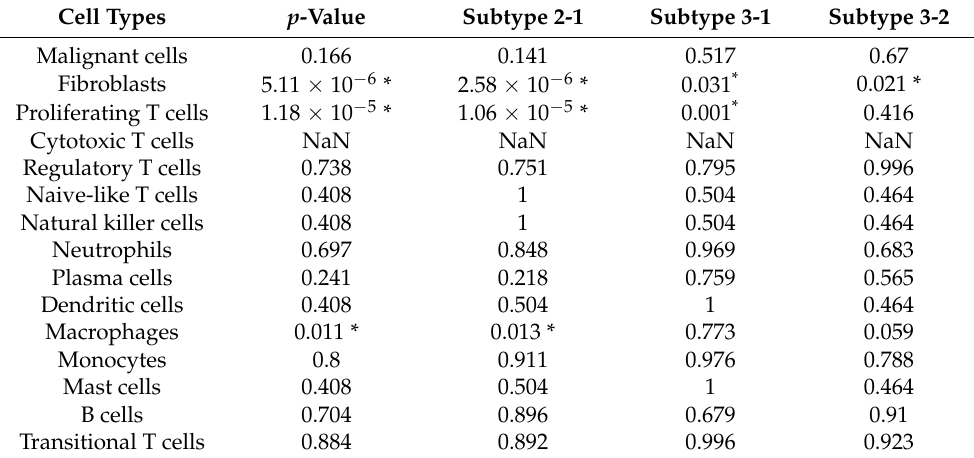
Table 3. Immune microenvironment cellular fraction differences of imaging subtypes in the imaging- subtype discovery cohort. A BC-specific reference signature matrix developed from single-cell transcriptome data was used to estimate the relative proportion of 15 cell types in the bulk RNA-seq data. Then, the differences in the cellular fraction of imaging subtypes were